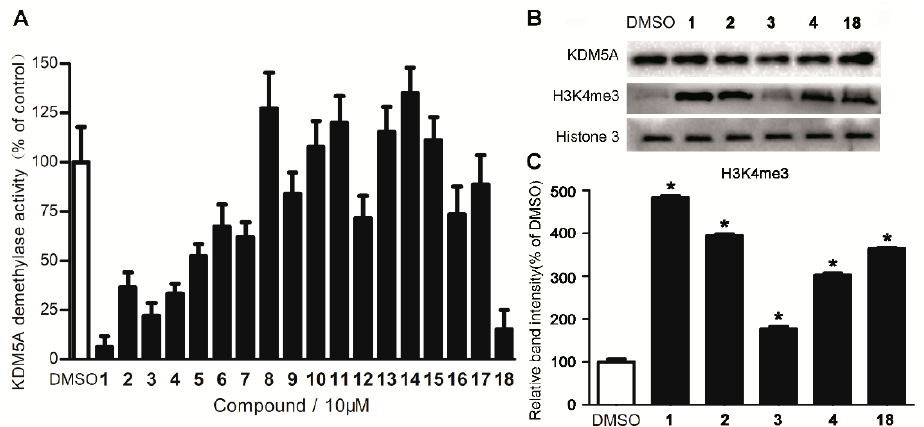
Figure 1. Identification of compound 1 as a novel KDM5A demethylase inhibitor. ( A ) KDM5A demethylase inhibition by compounds 1 – 18 in a chemiluminescence assay. ( B ) Compounds 1 – 4 and 18 inhibit KDM5A activity in MDA-MB-231 cells was revealed by Western blotting. ( C ) Densitometry analysis of H3K4me3 levels. Results are representative of three independent experiments. Data are represented as mean ± SD. Student’s t test, * p < 0.05.